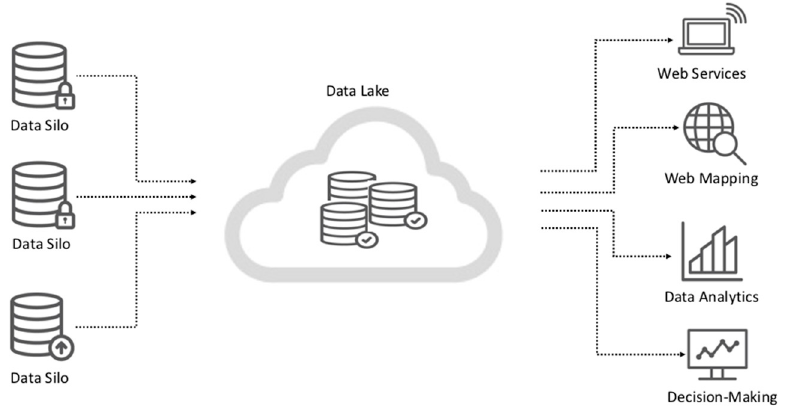
Figure 9. Data lake SDI architecture.